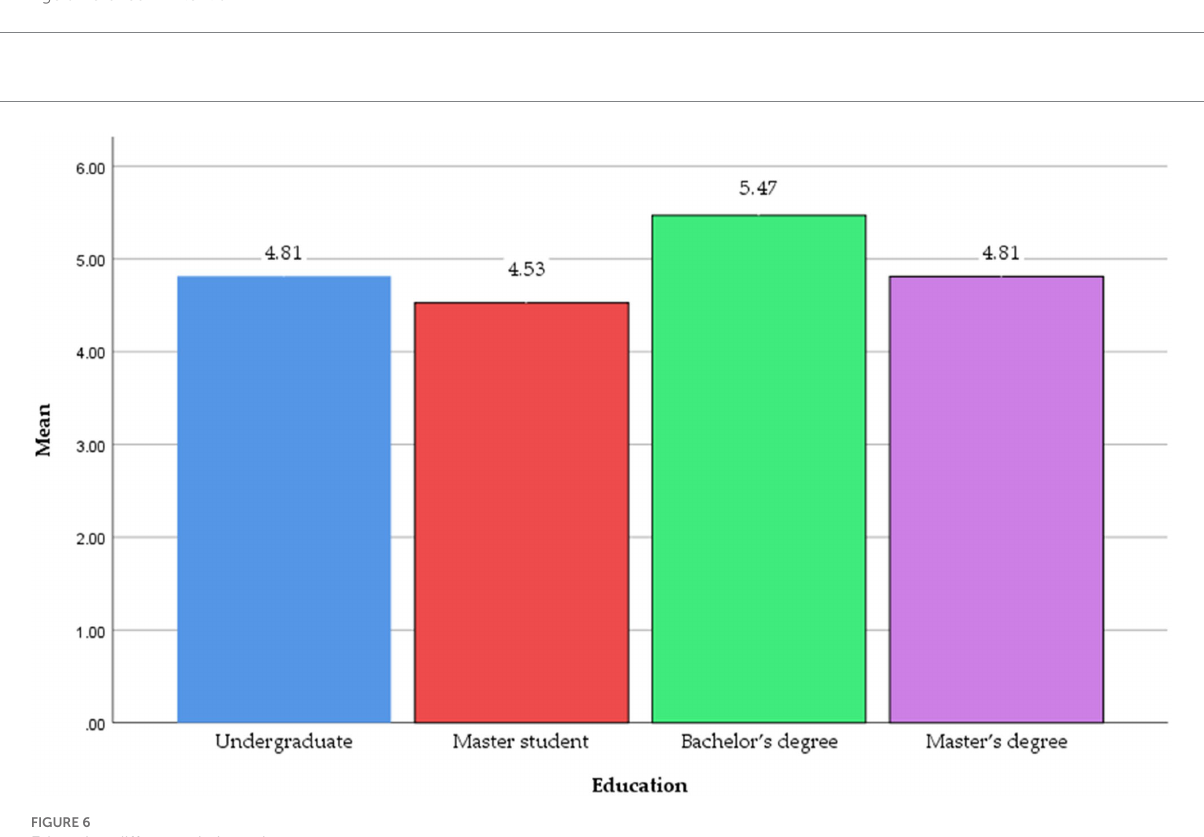
FIGURE 5 Age difference in intention.